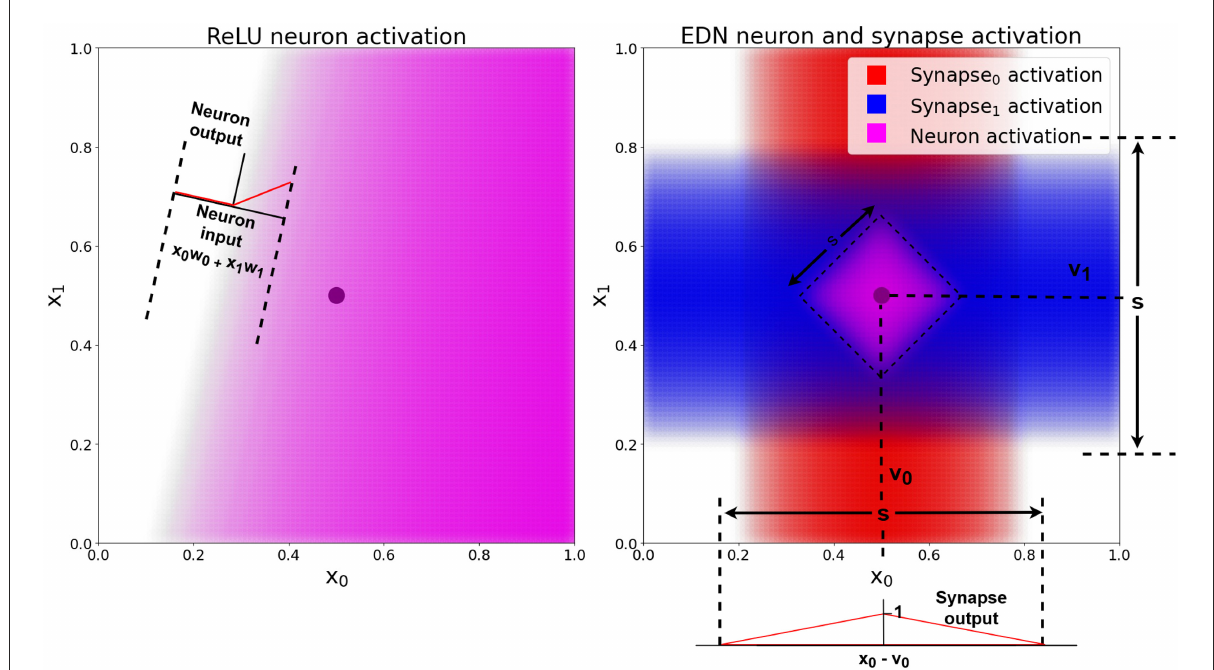
FIGURE2 A comparison of a standard ANN neuron with ReLU activation and an EDN neuron’s activation. The black dot is a single data point, the pink shaded area shows the output activation of the neuron in both cases, with a deeper color representing a higher level of activation. The red and blue shaded areas represent the level of activation of each synapse, which possess the triangle kernel shown in the bottom right, with spread s and centered at individual values of v . The EDN neuron’s activity is the average of the incoming synapse activity and is also passed along an outgoing synapse using a triangle kernel with the same s value and v = 1. This output synapse acts to threshold neuron activity and create the bounded purple area in the input space in which the neuron is